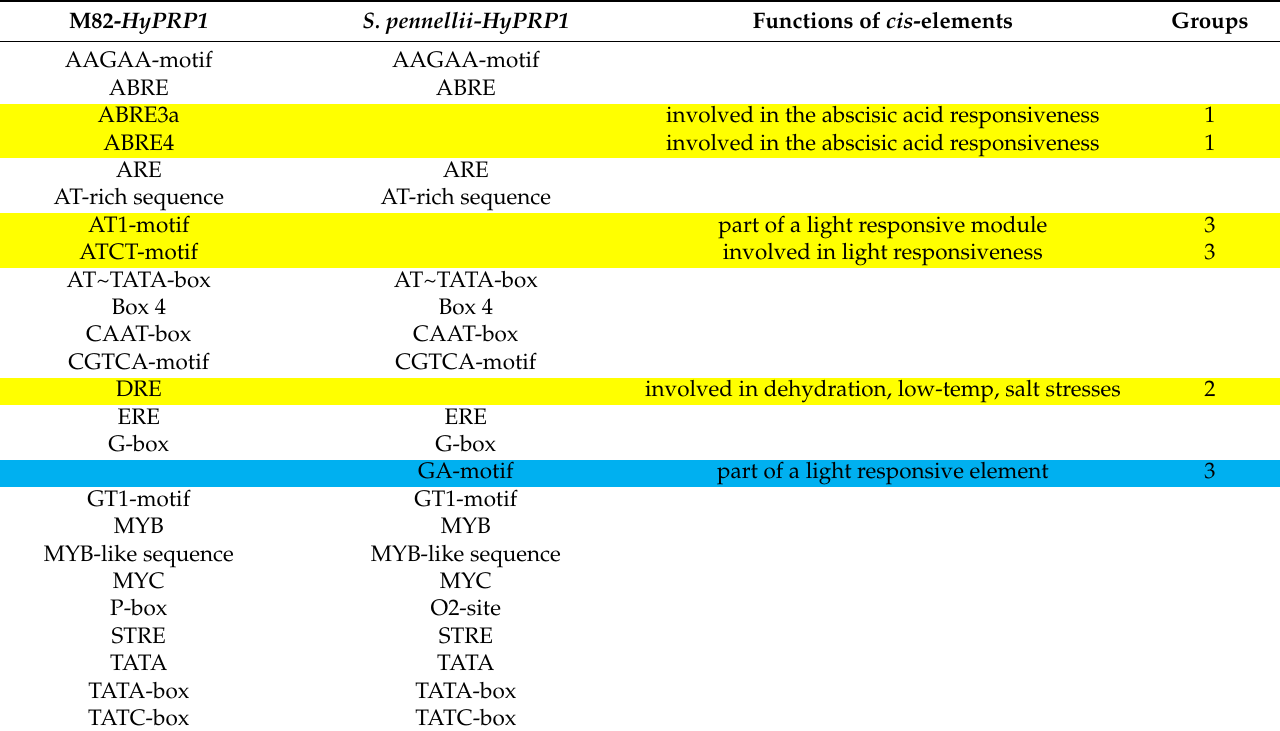
Figure 2. Methylation analysis and heterologous expression of HyPRP1. ( A ) Peptide alignment of HyPRP1 proteins of SlHyPRP1 and SpHyPRP1. ( B ) Analysis of the DNA methylation of SlHyPRP1 at leaf and different fruit stages. Immature (17 D), mature green (MG), breaker (Br), and red ripe (Br + 10), and leaf. Ratio = 5mC/(5mC + C). ( C ) SlHyPRP1 and SpHyPRP1 were expressed in Escherichia coli and the isopropyl-1-thio- β -galactopyranoside (IPTG) induced protein product was electrophoretic separation in a 10% polyacrylamide gel. The E. coli cells harboring pET- SpHyPRP1 ( HyPRP1 from Solanum pennellii : named P), pET- SlHyPRP1 ( HyPRP1 from Solanum lycopersicum M82: named M), and control pET-E1 (vector control: named VC). Three different clones of each transformed E. coli were analyzed. Table 1. The differences for the cis -elements in the promoter sequence of HyPRP1 between Solanum pennellii and M82.